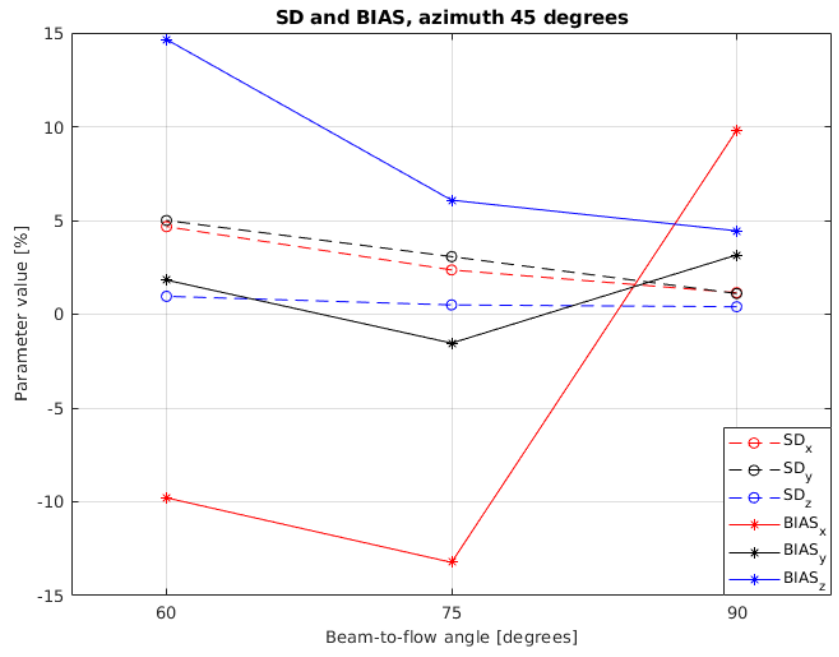
Figure 7. RSD and RB for simulations with (90, 75, 60) degrees beam-to-flow anlges and 45 degrees rotation angle. The dashed lines show the relative standard deviation, the solid lines show the relative bias. The red color is v x , the black is v y and the blue is v z components of the